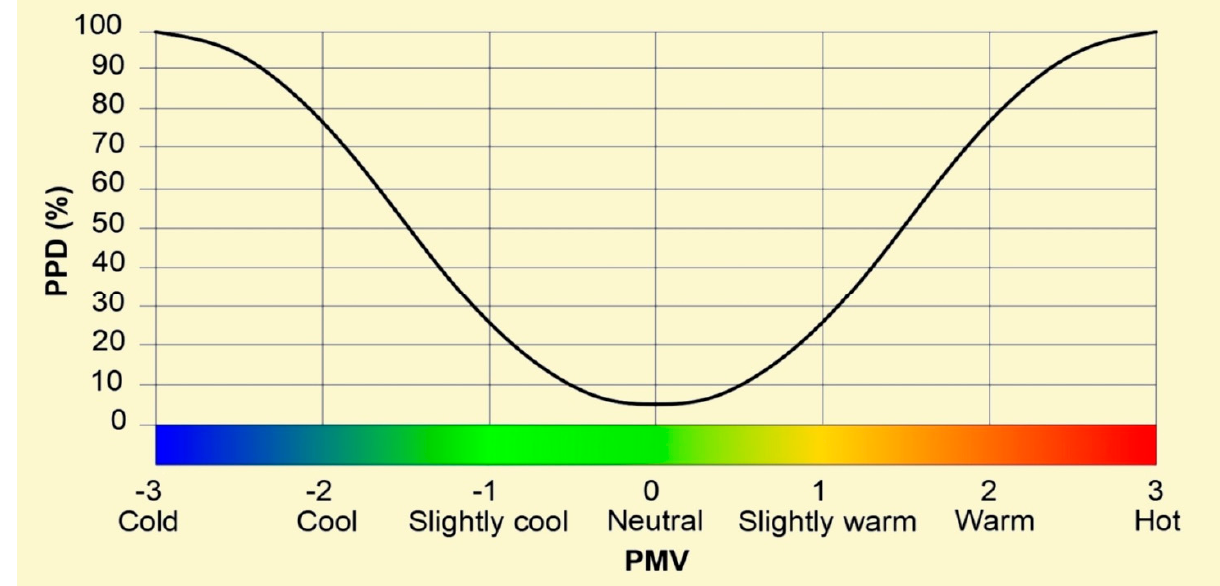
Figure A1. Reference Values for PMV and PPD Parameters